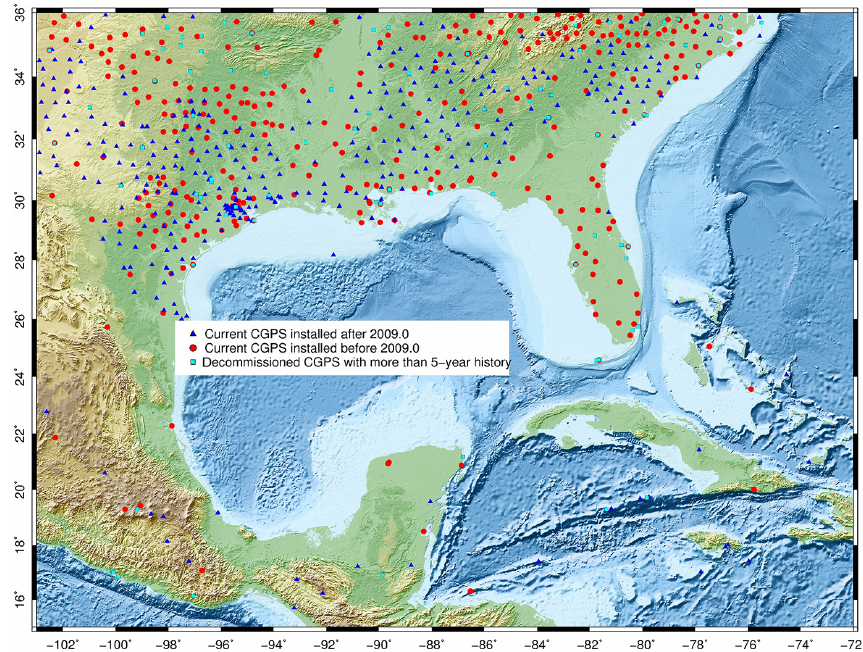
Figure 1. Map showing current CGPS stations in the GOM region. Blue triangles represent current CGPS installed in and after 2009. Red circles represent current CGPS installed before 2009. Grey squares represent decommissioned CGPS that have data spanned for more than 5 years. Data are available through NGS and